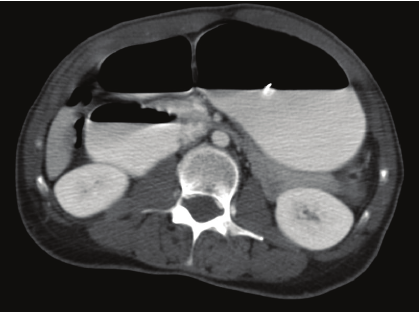
Figure2:CT-imagingdemonstratingSMAsyndromewithresulting compression of duodenum due to aorta and superior mesenteric